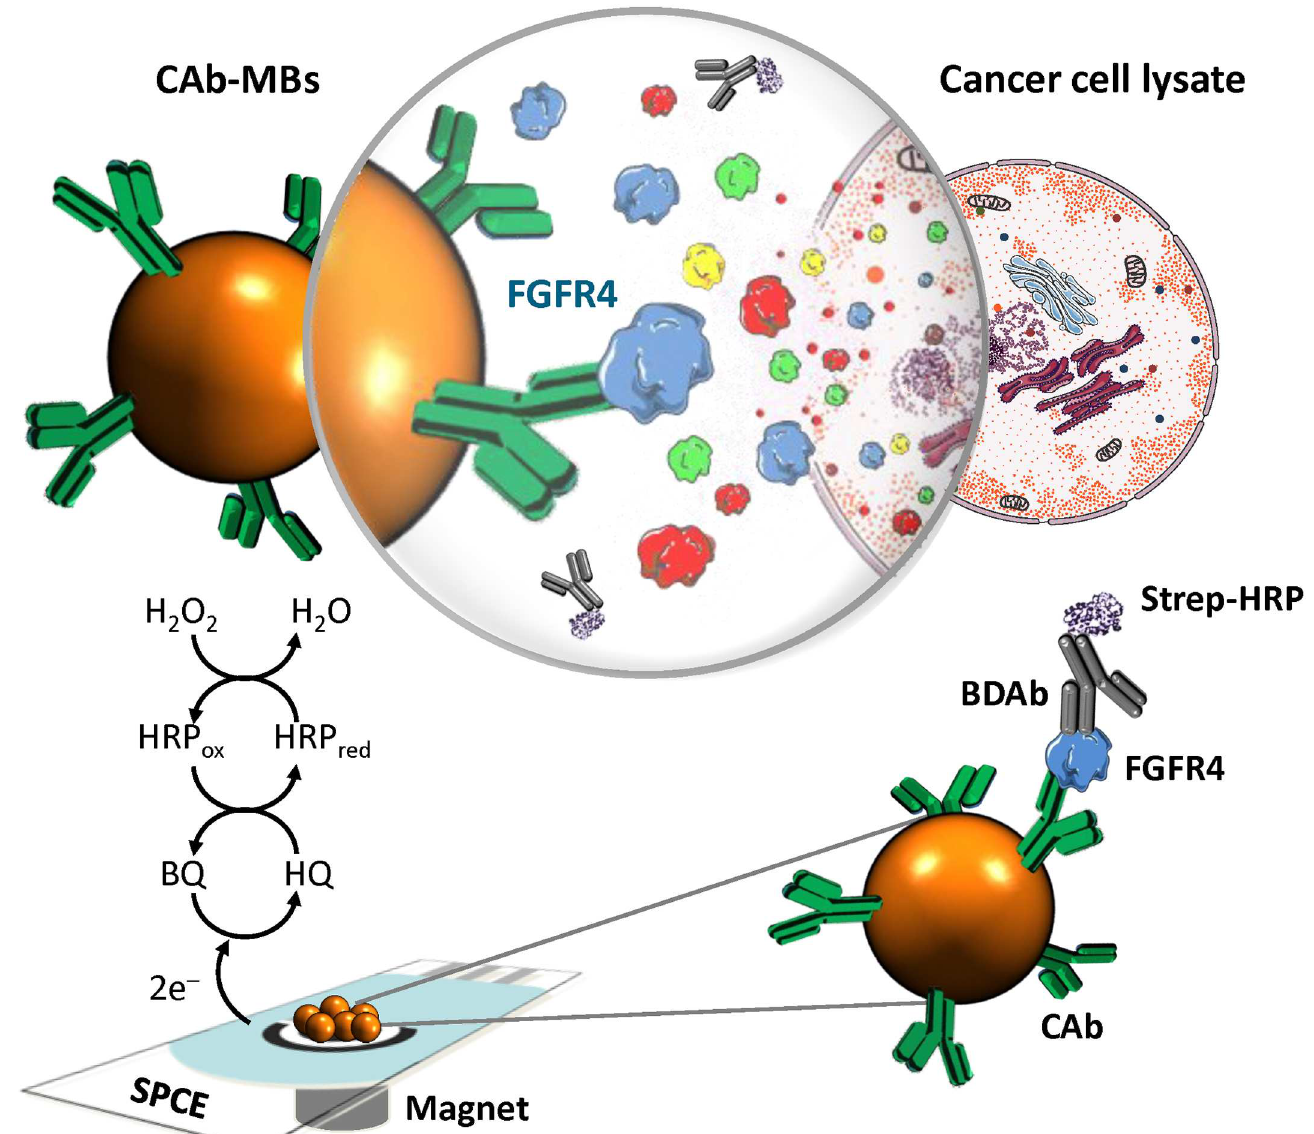
Fig 1. Schematic representation of the amperometric sensor for FGFR4 determination using magnetic immunocarriers and a sandwich format.